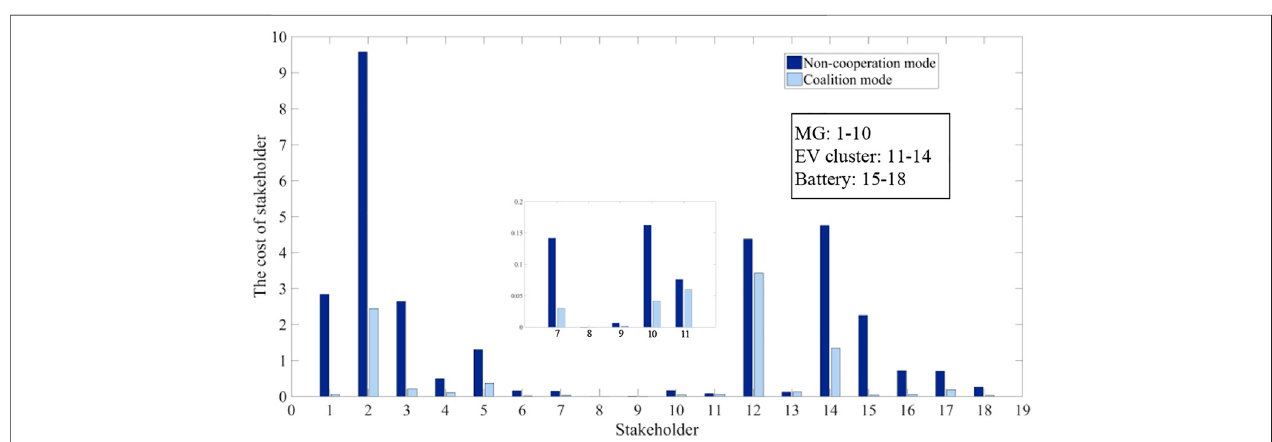
FIGURE 12 | The cost comparison of stakeholders between non-cooperation mode and coalition